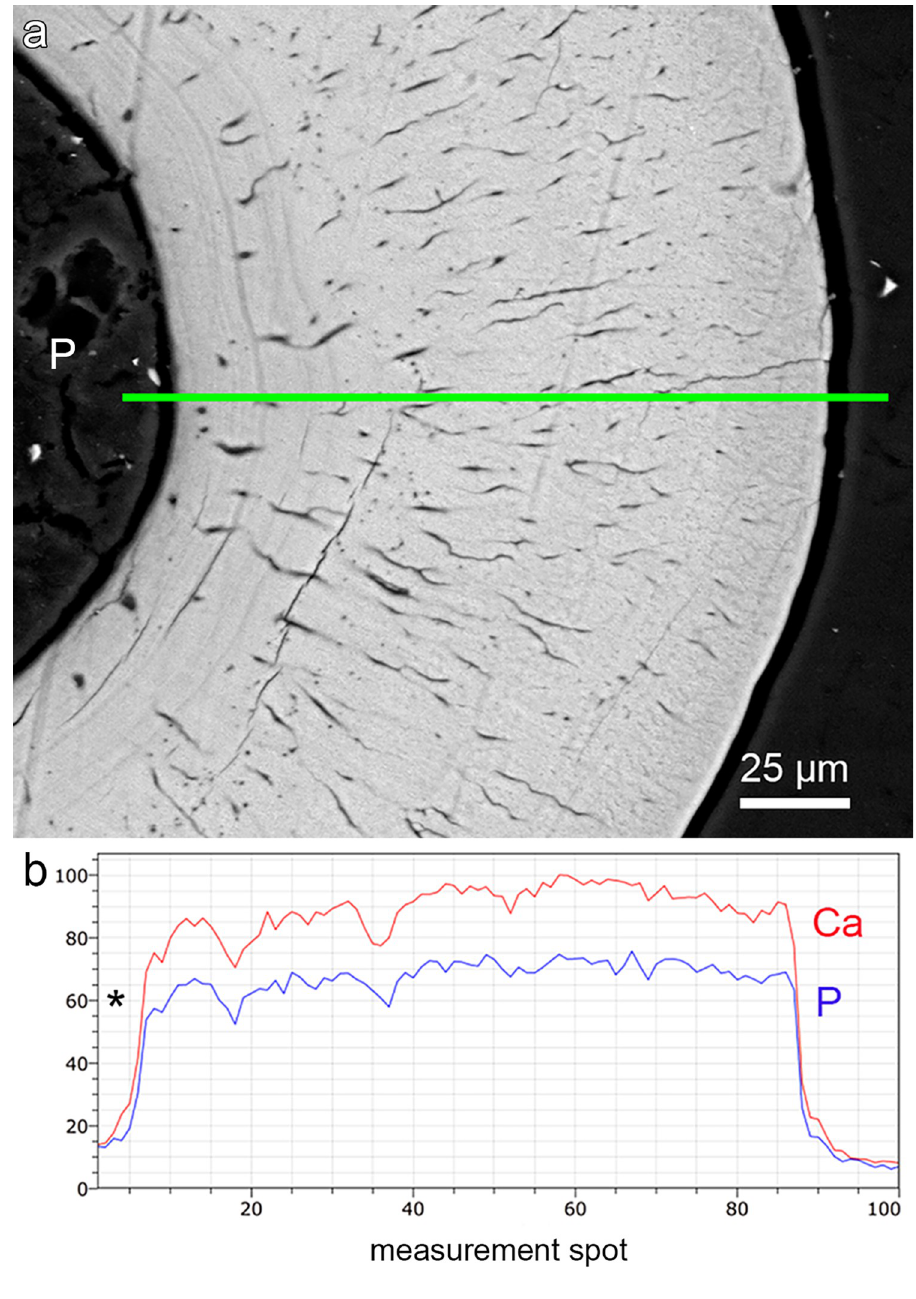
Fig 6. Transverse section through the tip region of a right first dentary tooth of Anoplogaster cornuta . (a) SEM-BSE image showing uniform gray level distribution (indicative of homogeneous mineralization) of the dentin. The position of the EDS line profile is indicated by the green line. P: Pulp cavity. (b) SEM-EDS line profile showing variation of calcium (Ca) and phosphorus (P) concentrations (relative values) across the dentinal wall. An enameloid layer with higher Ca and P concentrations is not present. Asterisk: Pulp